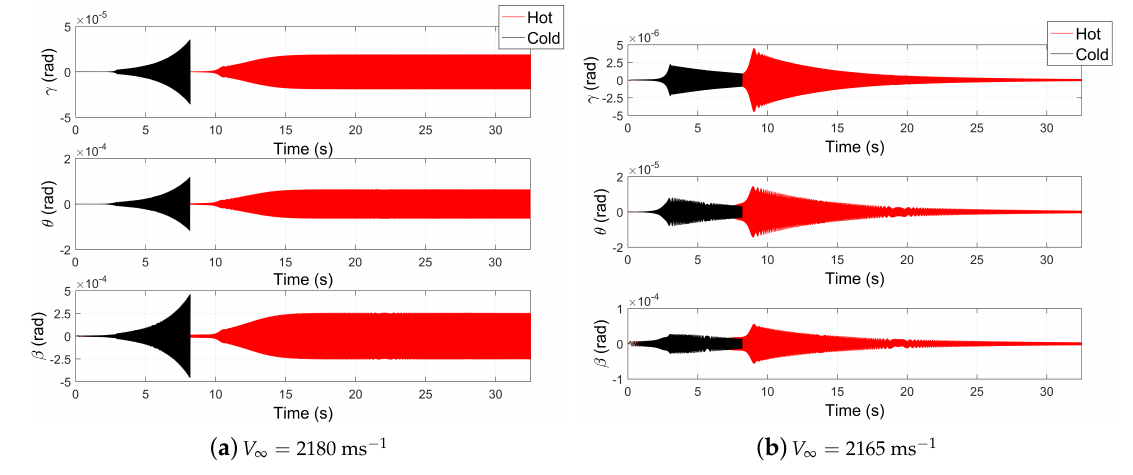
Figure 8. Linear and nonlinear response of cold wing.